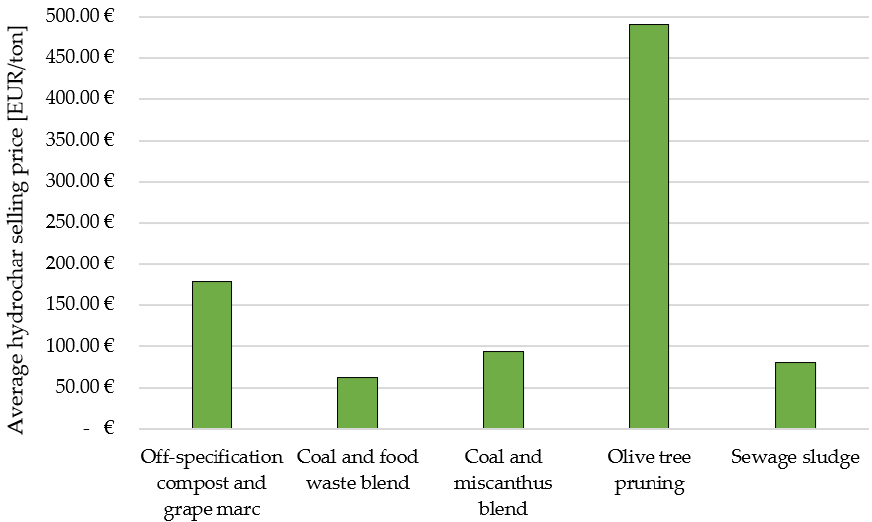
Figure 3. Average hydrochar selling price for different feedstocks .